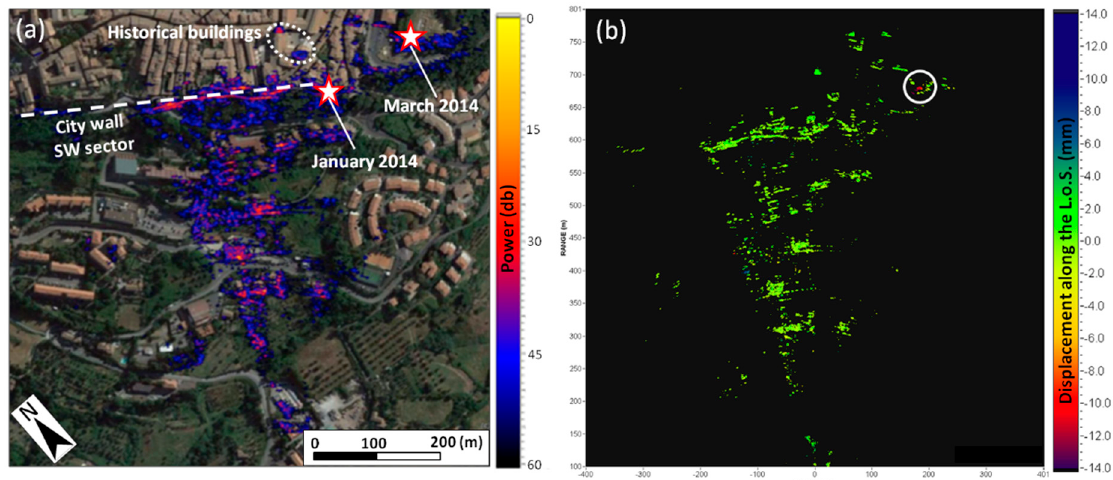
Figure 7. GB-InSAR 1 monitoring data: ( a ) geo-rectified radar power image on ortophoto, displaying the main structures monitored and the winter 2014 collapses (stars); ( b ) cumulated displacement map highlighting the unstable bastion sector (white circle): stable areas in light green, areas characterized by displacement toward the sensor LOS (colors from yellow to purple), areas characterized by displacements away from the sensor LOS (colors from dark green to blue).